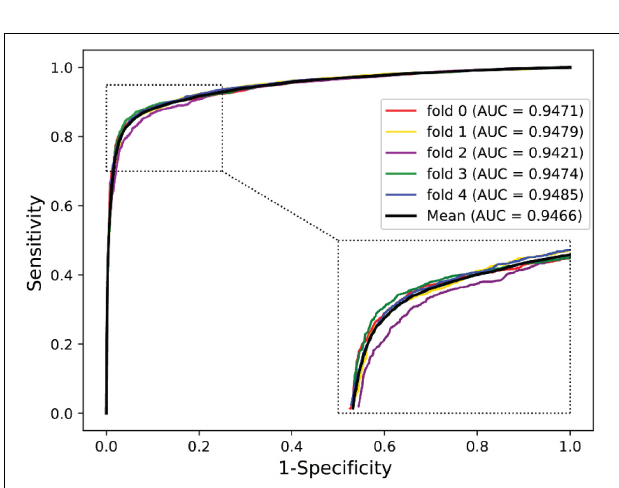
FIGURE 3 | The ROC curves of our approach on the Zea mays dataset under five-fold CV.